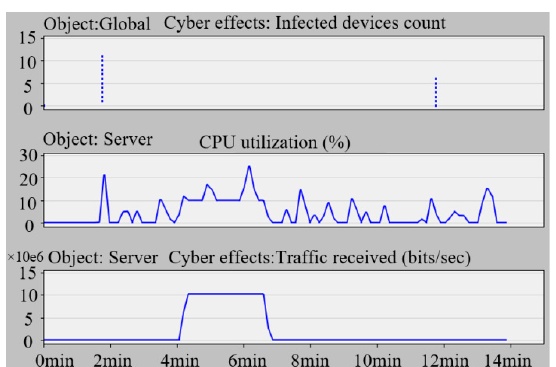
Figure 14. Results of injection, CPU, and traffic occupation during attacks.